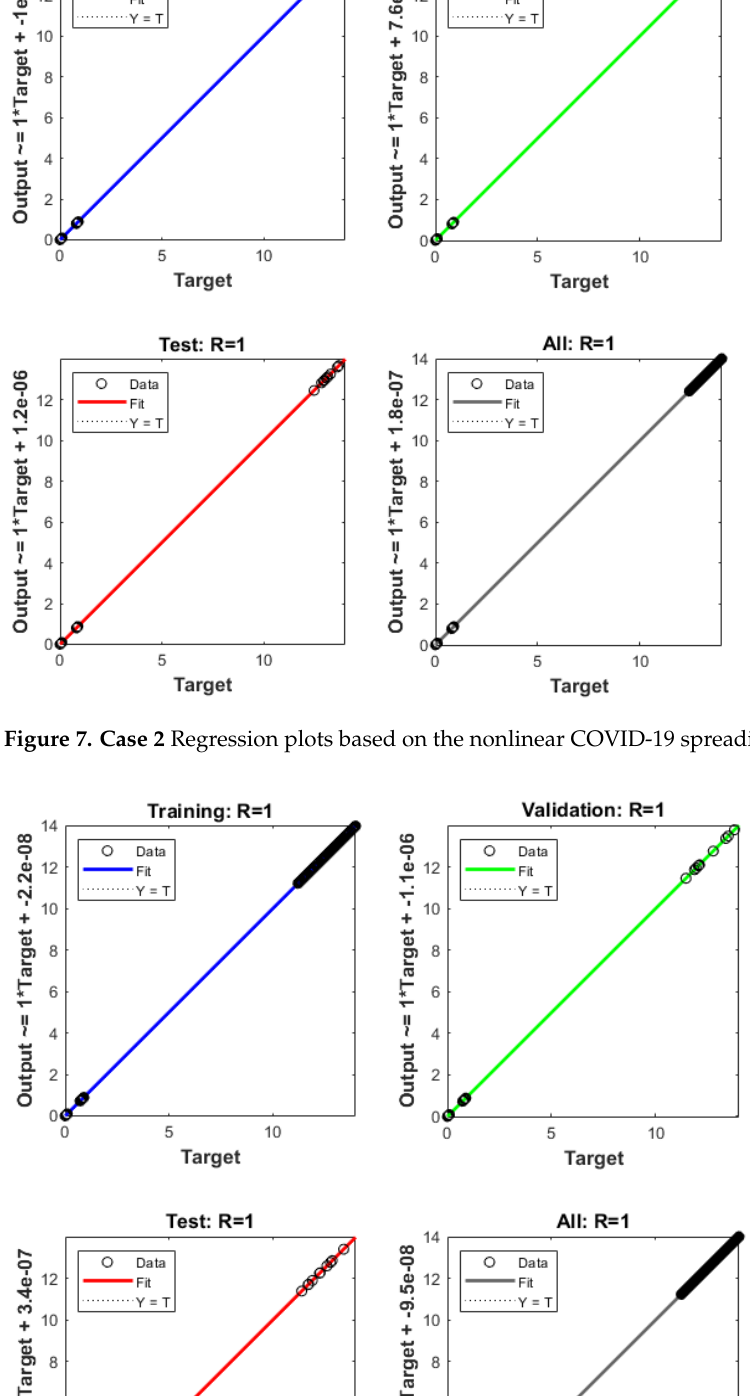
Figure 6. Case 1 Regression plots based on the nonlinear COVID-19 spreading model.